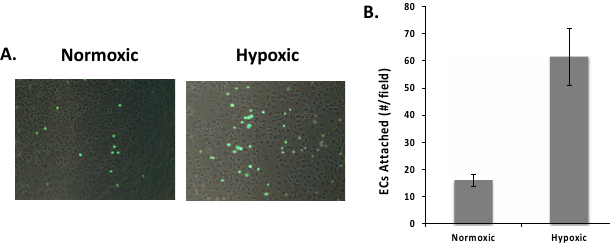
Figure 1. Hypoxia enhances endothelial cell attachment to retinal pigmented epithelial (RPE) cell layers. RPE cells were maintained under normoxic (20% pO 2 ) and hypoxic (1% pO 2 ) conditions for 48 h prior to cell attachment. Fluorescently labeled retinal endothelial cells (RECs) were allowed to attach for 1 h and fixed prior to visualization ( A ) by fluorescence microscopy and ( B ) counting (4 fields / well; 3 wells / condition; biological replicates ( N ) = 3; technical replicates ( n ) = 4). The data in panel ( B ) are expressed as the average number of cells per field ± SEM. Hypoxia caused a statistically significant increase in REC attachment ( p < 0.05).